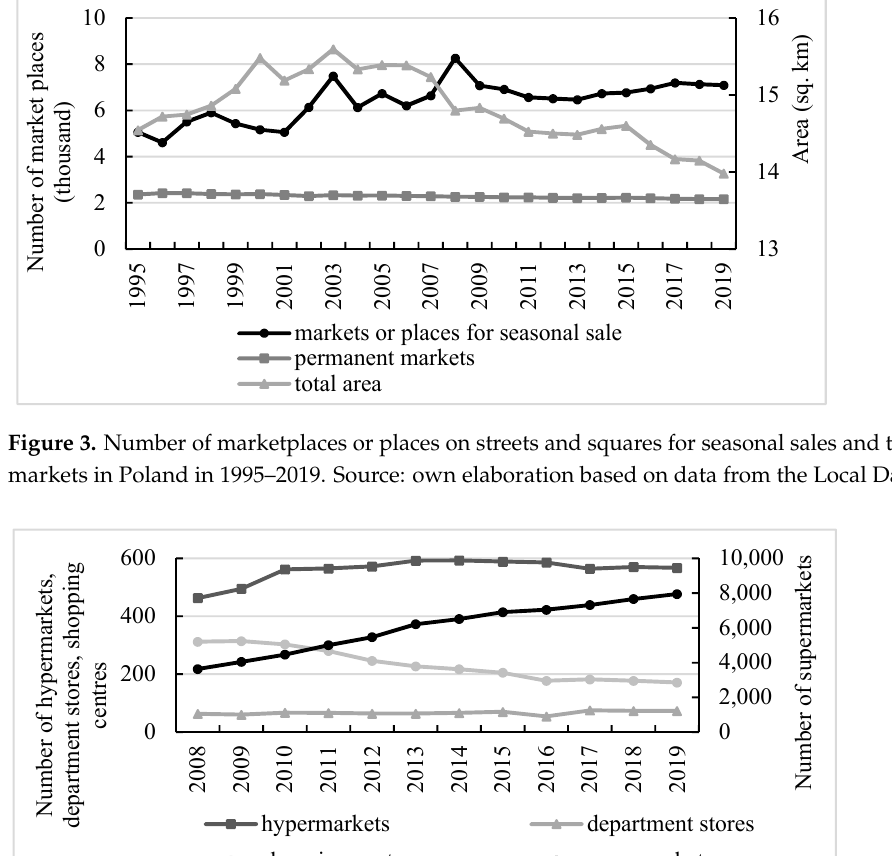
Figure 3. Number of marketplaces or places on streets and squares for seasonal sales and the area of markets in Poland in 1995–2019. Source: own elaboration based on data from the Local Data Bank.